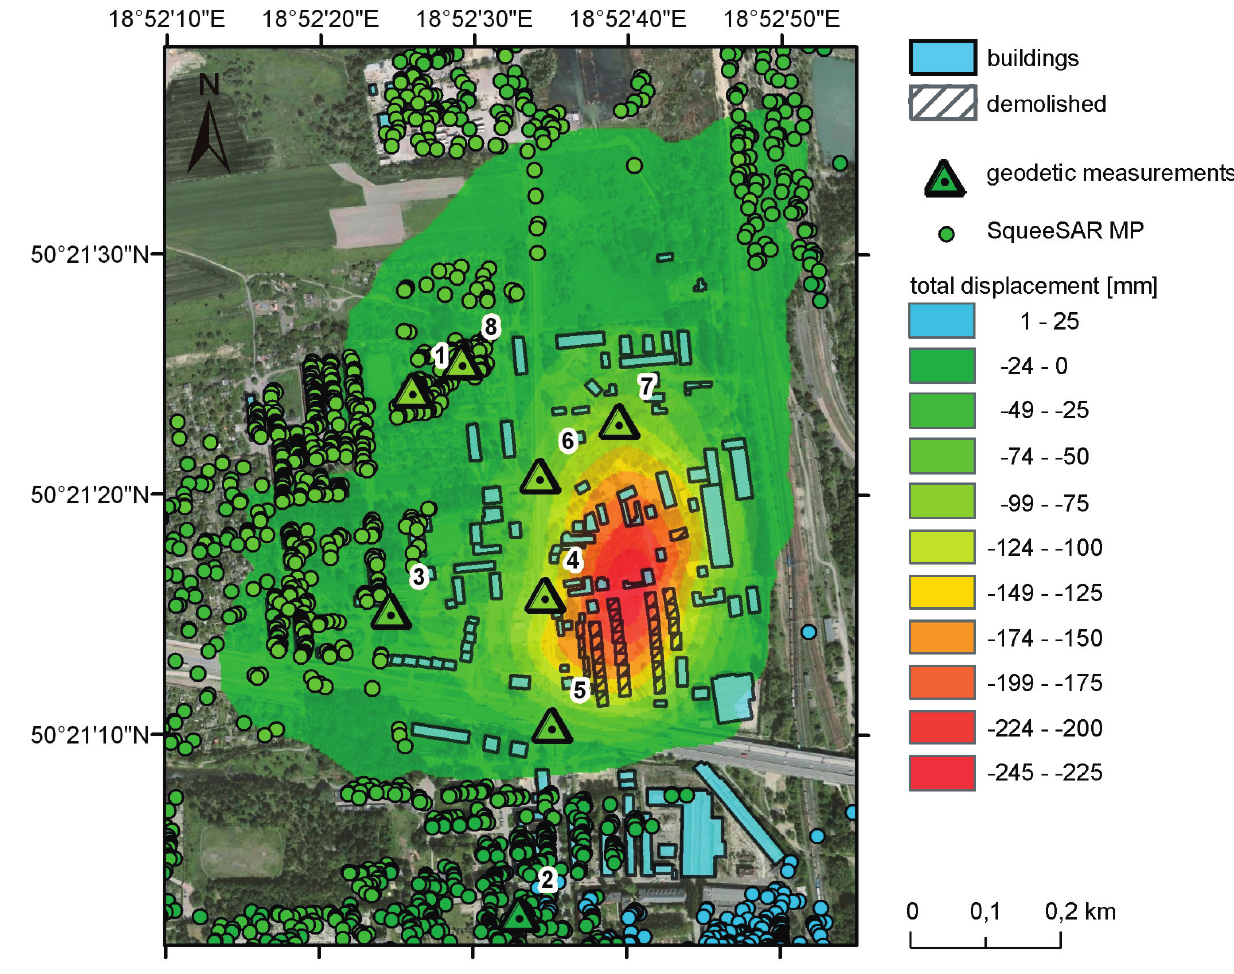
Figure 13. Integrated subsidence map over Karb settlement covering period 05 July 2011–29 August 2011. Table 5. Comparison of the results from Synthetic Aperture Radar Interferometry (InSAR) and geodetic measurements projected to TerraSAR-X Line of Sight over Karb